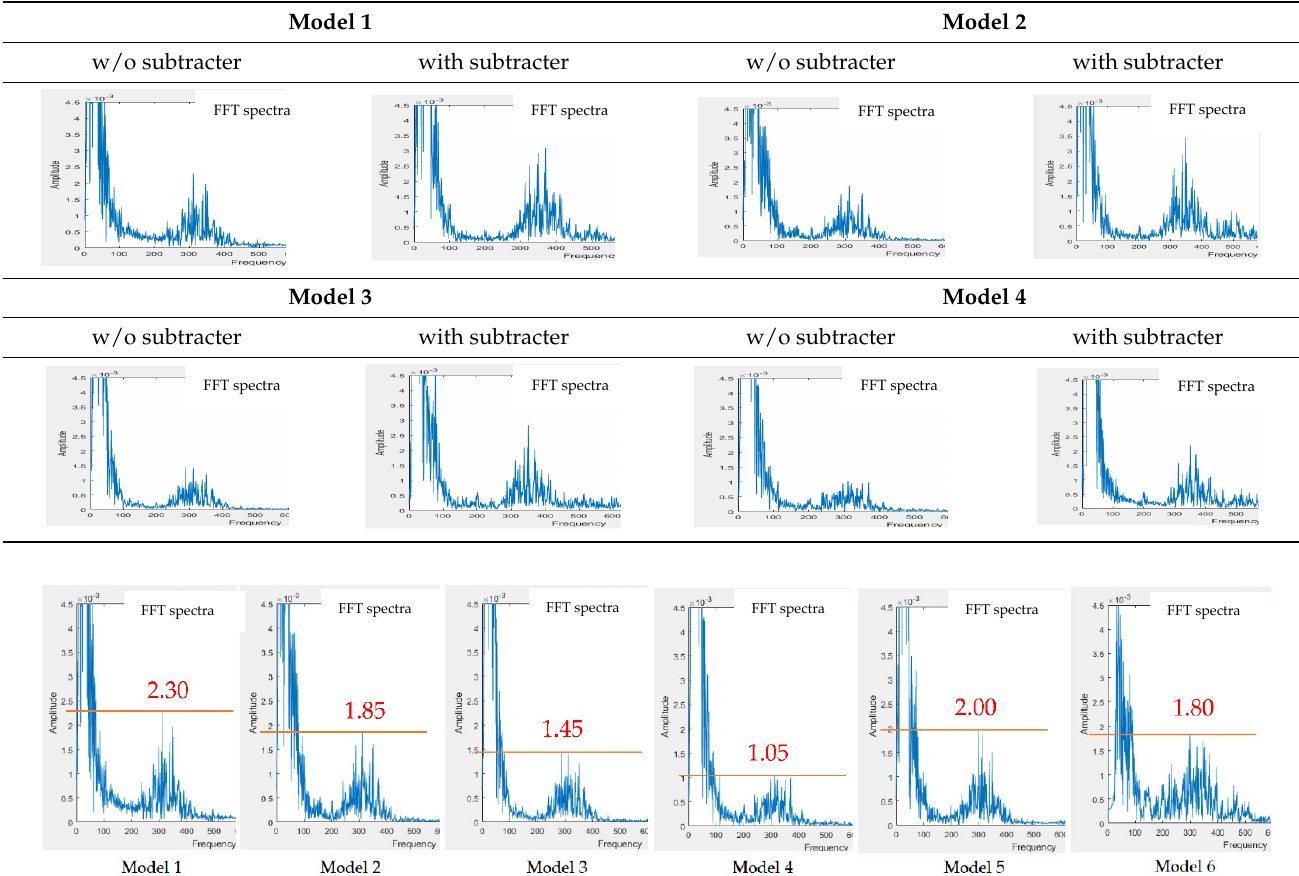
Table 3. Comparison of FFT spectra of heart sound signals with and w/o the subtracter.